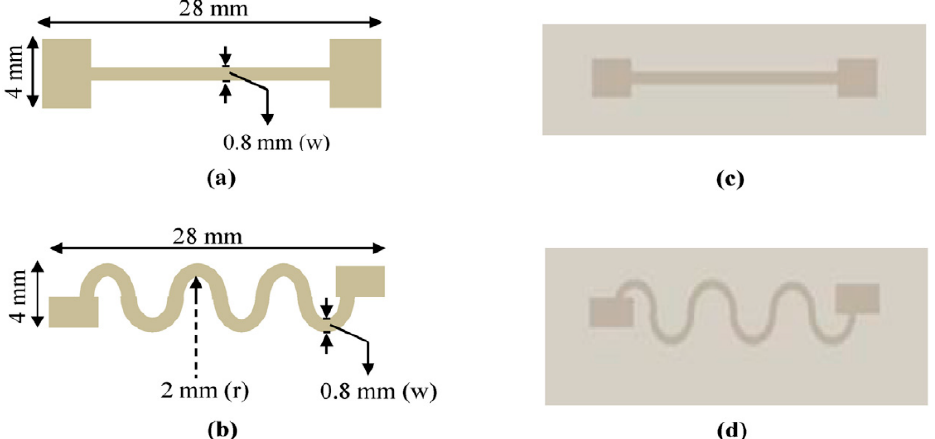
Figure 9. Schematic of ( a ) straight-line and ( b ) wavy-line configurations of the strain sensor. Images of screen-printed ( c ) straight- and ( d ) wavy-line configuration-based strain sensor TPU substrate. Reprinted with permission from Ref. [87]. Copyright 2018, Elsevier.